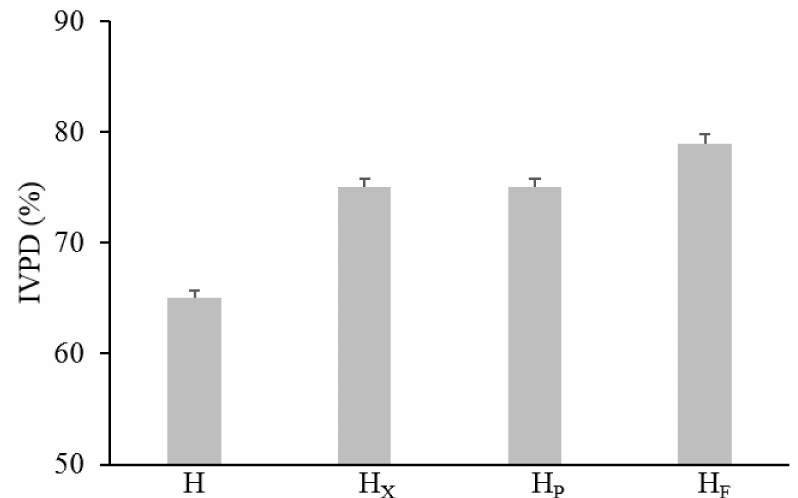
Figure 3. In vitro protein digestibility of raw and bioprocessed hemp. H, untreated hemp dough; H X , hemp dough treated with xylanase Depol 761P (1% wt / wt of fiber); H P , hemp dough treated with protease VeronPS (2.5% wt / wt of protein); H F , hemp dough fermented by Lactiplantibacillus plantarum 18S9 and Leuconostoc mesenteroides 12MM1 (ratio 1:1, final cell density of circa 7 log10 cfu / g). All treated samples were incubated at 30 ◦ C for 24 h. All treated samples were incubated at 30 ◦ C for 24 h.